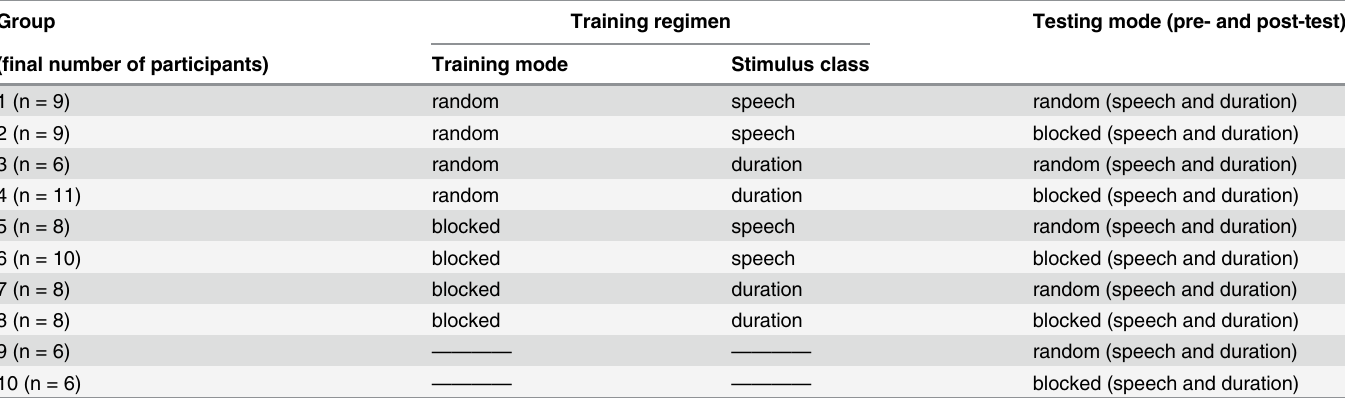
Table 1. Training regimen (mode and stimulus class), testing conditions and fi nal number of participants in each of the 10 study groups.